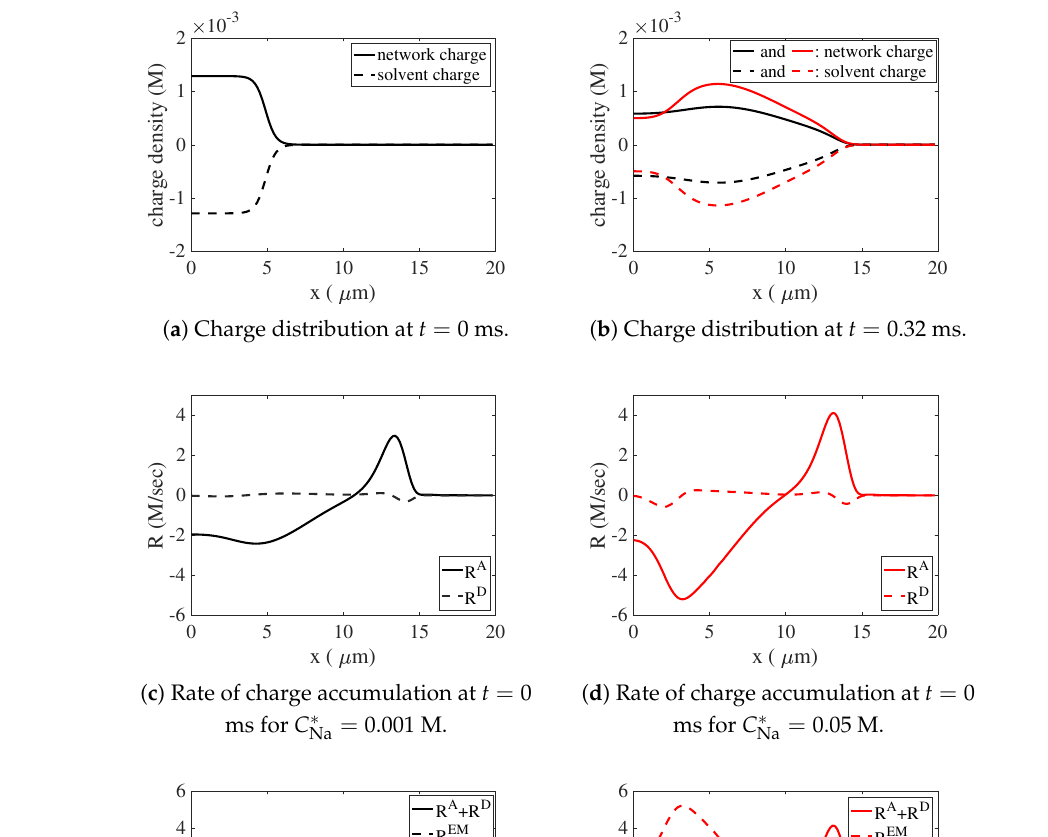
( f ) Rate of charge accumulation at t = 0 = 0.05 M. m for C ∗ Na